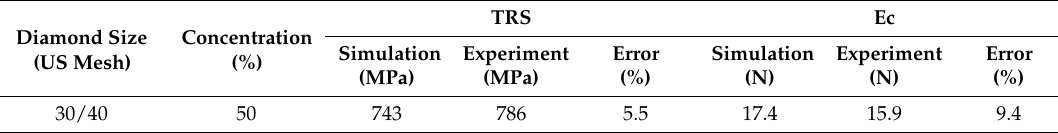
Table 5. TRS of the diamond segment: results of experiment and DEM